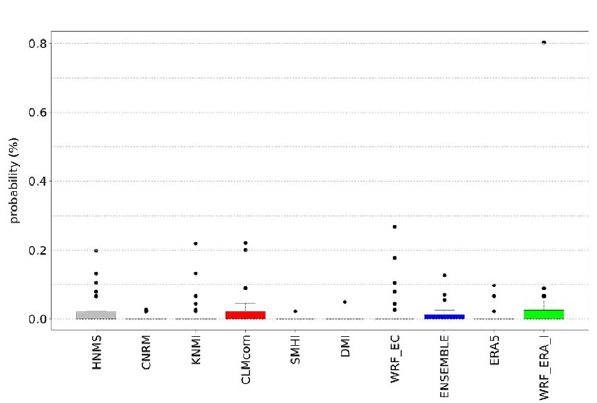
Figure 5. Box plot presenting RR20ID copula method probabilities for observations and